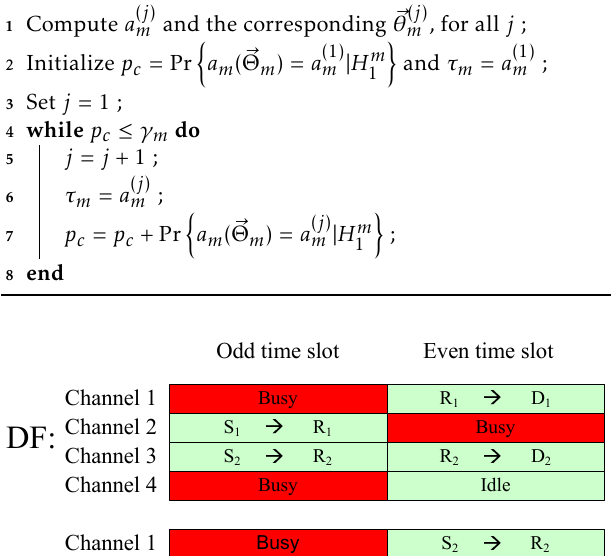
Algorithm 1: Algorithm for Computing the Optimal Sensing Threshold